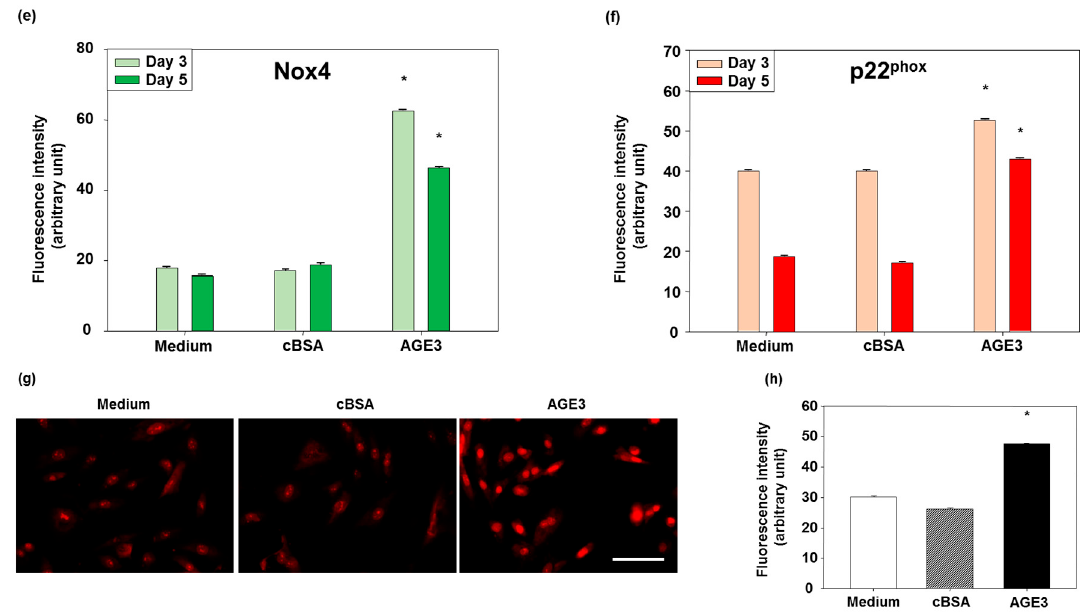
Figure 5. Effects of AGE3 on the protein expression of Nox4 and p22 phox . A7r5 cells were treated with medium alone, cBSA or AGE3-BSA for three and five days. After treatment, Nox4 and p22 phox proteins were analyzed by immunofluorescence staining, as described in Materials and Method. Representative photomicrographs of Nox4 immunofluorescence staining of Day 3 and 5 are shown in ( a , b ) respectively, and quantified fluorescence intensities in ( e ). 1–3; medium only (no treatment), 4–6; cBSA treatment, and 7–9; AGE3 treatment. Representative photomicrographs of p22 phox immunofluorescence staining of Day 3 and 5 are shown in ( c , d ) respectively, and quantified fluorescence intensities in ( f ). Higher magnification photomicrographs are shown in the insets for localization of the expressed proteins. Cellular ROS levels were analyzed by DHE assay after treating the cells for five days. Representative photomicrographs of DHE fluorescence are shown in ( g ); and quantified fluorescence intensities in ( h ). Numerical data are presented here as average ± SE of at least four experiments. * p < 0.05 vs. medium or cBSA of same time period. Scale bar = 100 µm.